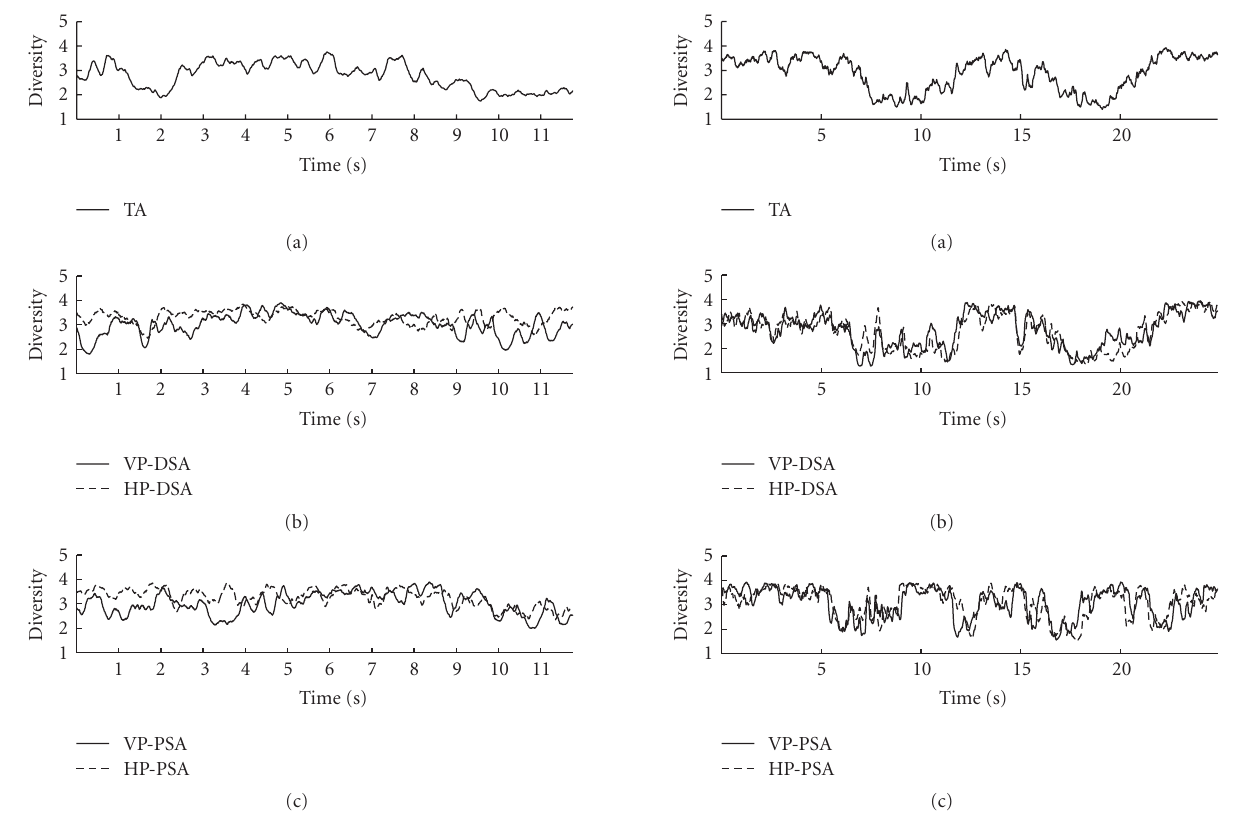
Figure 12: Diversity measure of the channels at each array on Slater Street.